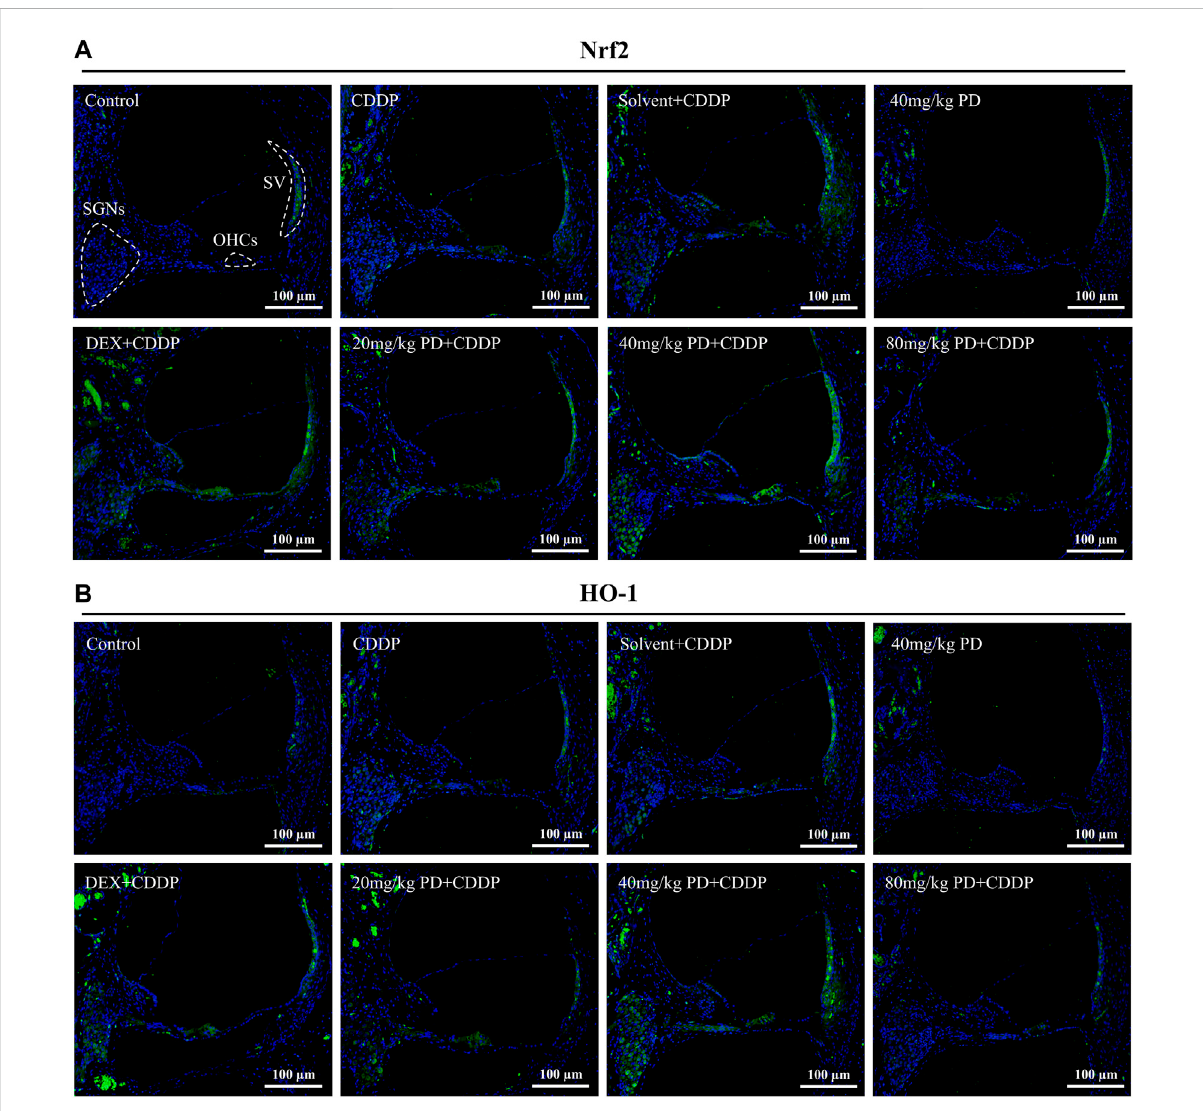
FIGURE 7 PDincreases theantioxidantcapacityofcochlea after cisplatin administration.Representativeimmuno fl uorescence labellinginthecochleafor Nrf2 (green, (A) and HO-1 (green, (B) , double stained with DAPI in blue. The three dotted areas are SGNs, OHCs and SV. (A) and (B) In the control group, Nrf2 and HO-1 were slightly expressed in SGNs, OHCs and SV. After cisplatin administration, Nrf2 translocation into the nucleus was increased,alongwiththeincreasedexpressionofNrf2andHO-1,andthegreen fl uorescenceintensitywasslightlyincreased.Theexpressionof Nrf2 and HO-1 was increased by PD and DEX before cisplatin administration, and the green fl uorescence intensity was higher than that of CDDP group. Scale bar, 100 μ